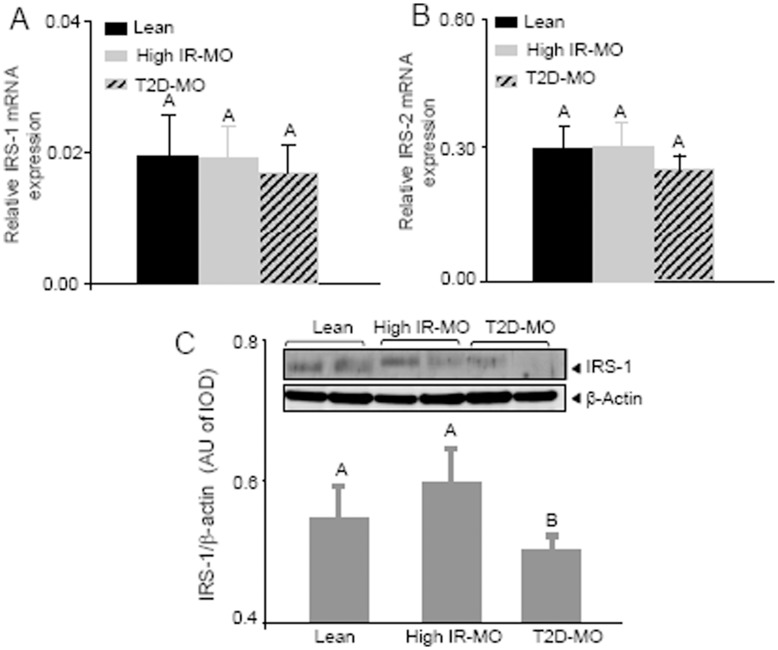
IRS-1 and IRS-2 expression in visceral adipose tissue from non obese, high IR-MO and T2D-MO subjects.(A and B) mRNA expression levels of IRS-1 and IRS-2: There were no changes in the mRNA expression of these genes between the lean and the morbidly obese groups. (C) IRS-1 protein levels were significantly decreased in VAT of T2D-MO subjects compared to high IR-MO and lean controls (Duncan; p<0.05). Significant differences (Duncan; p<0.05) are indicated with different words.